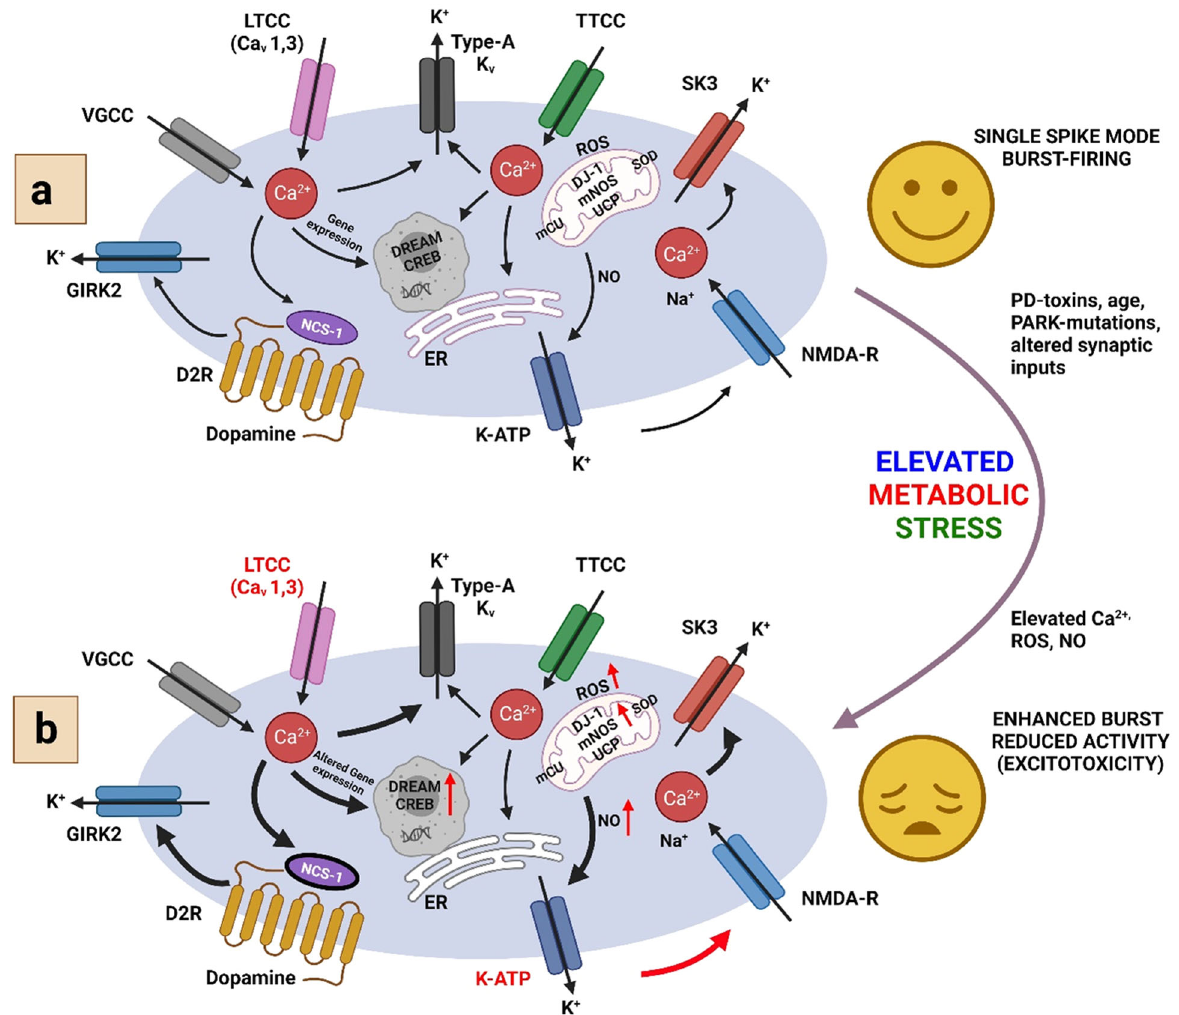
Fig. 8 Pictorial depiction of different types of ion-channels in the CNS and their mechanism of action under unstressed (Panel a) and stressed (Panel b) conditions. Panel a: Mechanistic view of networking of ion-channels in SN dopamine nerve cells in PD and other health states. Under physiological conditions, activity-dependent Ca 2 + loads due to (1) active participation of LTCC (L-type Calcium Chanel) and VGCC (Voltage-Gated Calcium Channel), with the help of KATP/NMDA-R, which mediates bursting activity and Ca 2 + -stimulated TCA (Tri Carboxylic Acid) cycle and m-NOS, (2) generated ROS for SN DA, which is controlled by ER (Endoplasmic Reticulum), mitochondrial Ca 2 + - buffering, UCP, ion-channels that reduces electrical activities like D2-AR/NCS1/GIRK-2, KATP, SK-3, anti-oxidative enzyme kinetics such as